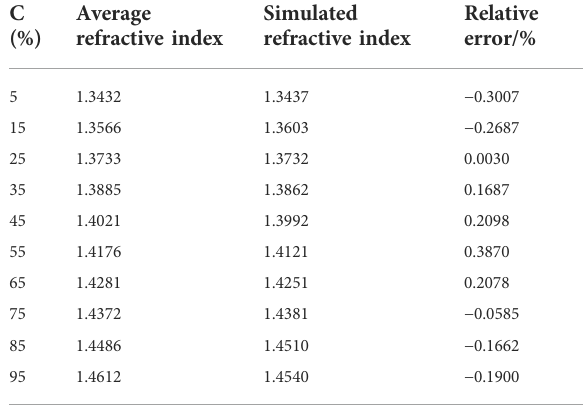
TABLE 6 Comparison of the actual measured and fi tted n